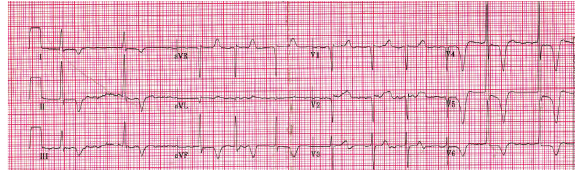
Figure 2: Preoperative ECG. Atrial fibrillation with voltage criteria for left ventricular hypertrophy and deep inferior/anterolateral T- wave